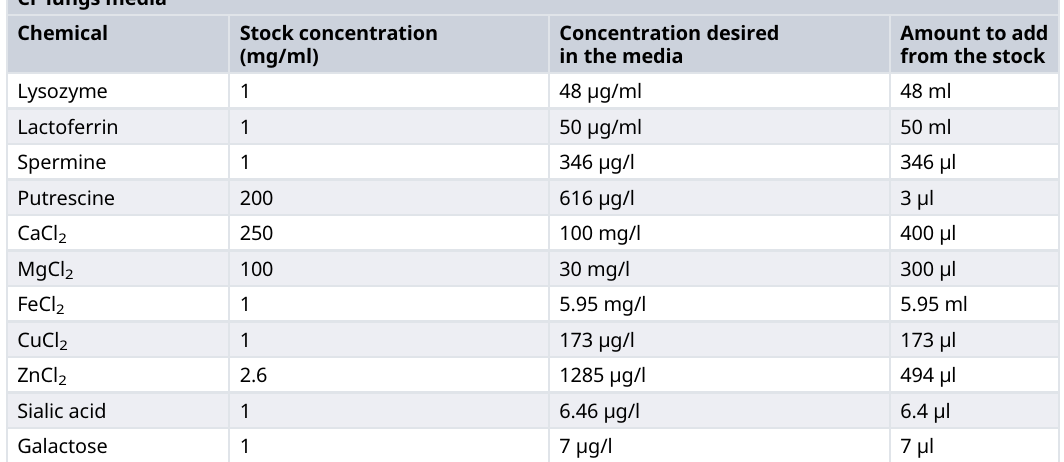
Table 8. Volumes of each chemical to add into the base media for 1liter CFLM.